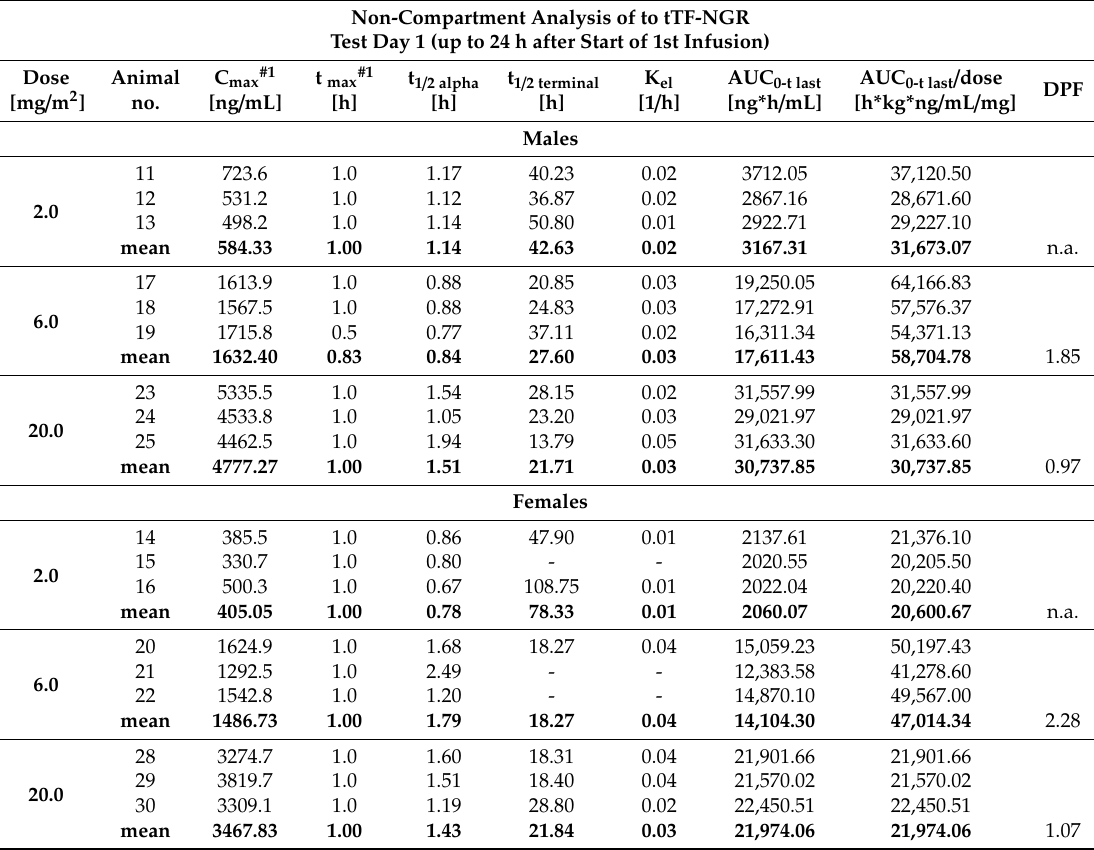
Table 3. Non-compartment analysis of tTF-NGR in beagle